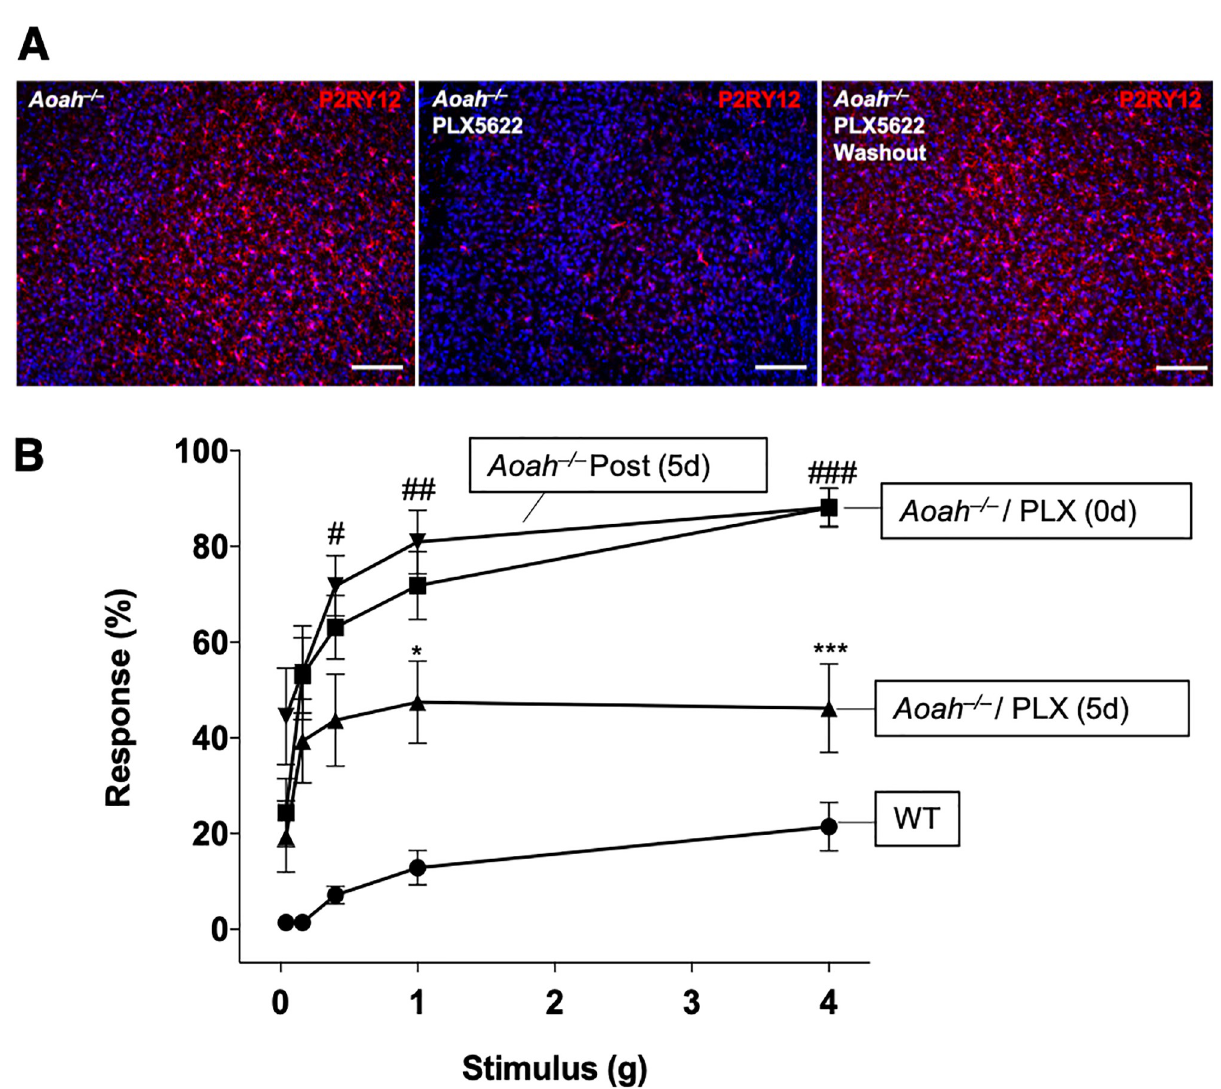
Fig 3. Pharmacologic ablation of microglia reduces pelvic allodynia of AOAH-deficient mice. A : Immunostaining of P2RY12 in AOAH-deficient prefrontal cortex from mice that were untreated (left panel), treated with 90 mg/kg of PLX5622 for 5d (middle panel) to eliminate central nervous system (CNS) microglia, or treated with PLX5622 for 5d followed by washout for 5d (right panel). DAPI staining nuclei shown in blue (scale bar: 30 μ m). Z-stacks were taken with a 10X objective. B : Stimulating the pelvic region with von Frey filaments revealed increased response in untreated and post-treated AOAH-deficient mice compared to WT and AOAH-deficient mice that were administered 90 mg/kg of PLX5622 for 5 days by oral gavage to eliminate CNS microglia (n = 7 mice for WT, n = 16 for baseline and PLX5622-treated AOAH-deficient mice, n = 11 mice for AOAH-deficient mice post-PLX5622 treatment; � P = 0.0365, ��� P = 0.0003 PLX5622 treatment compared to AOAH-deficient baseline, #P = 0.0380, ##P = 0.0089, ###P = 0.0014 Post (5 days) PLX5622 treatment compared to AOAH-deficient baseline, One-Way ANOVA followed by post-hoc Tukey HSD). Data represented as average response (%) ±